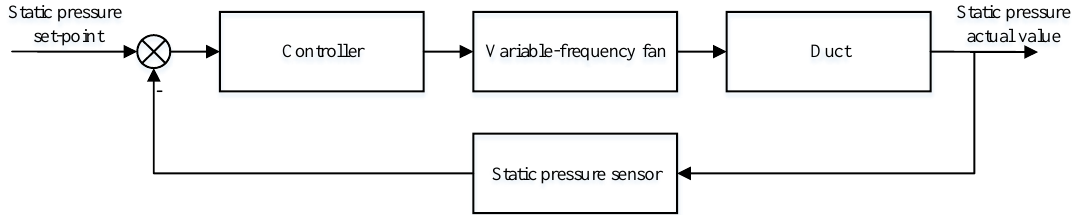
Figure 5. Structure of fan static pressure control.